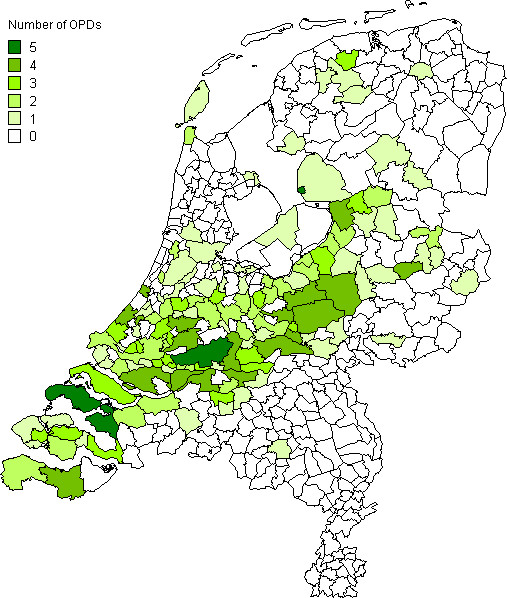
Number of OPDs per municipality or geographical entity